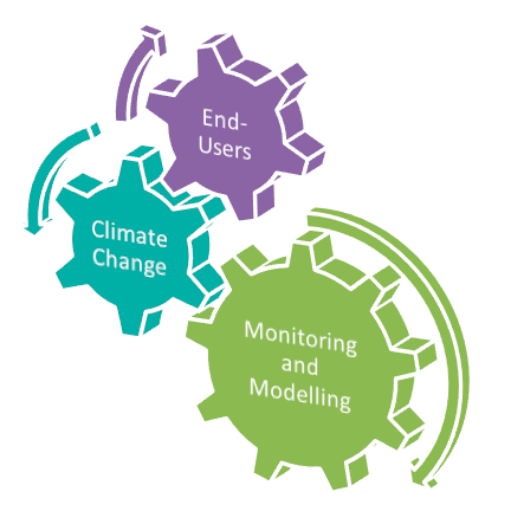
Figure 1. IMPECAF’s approach.